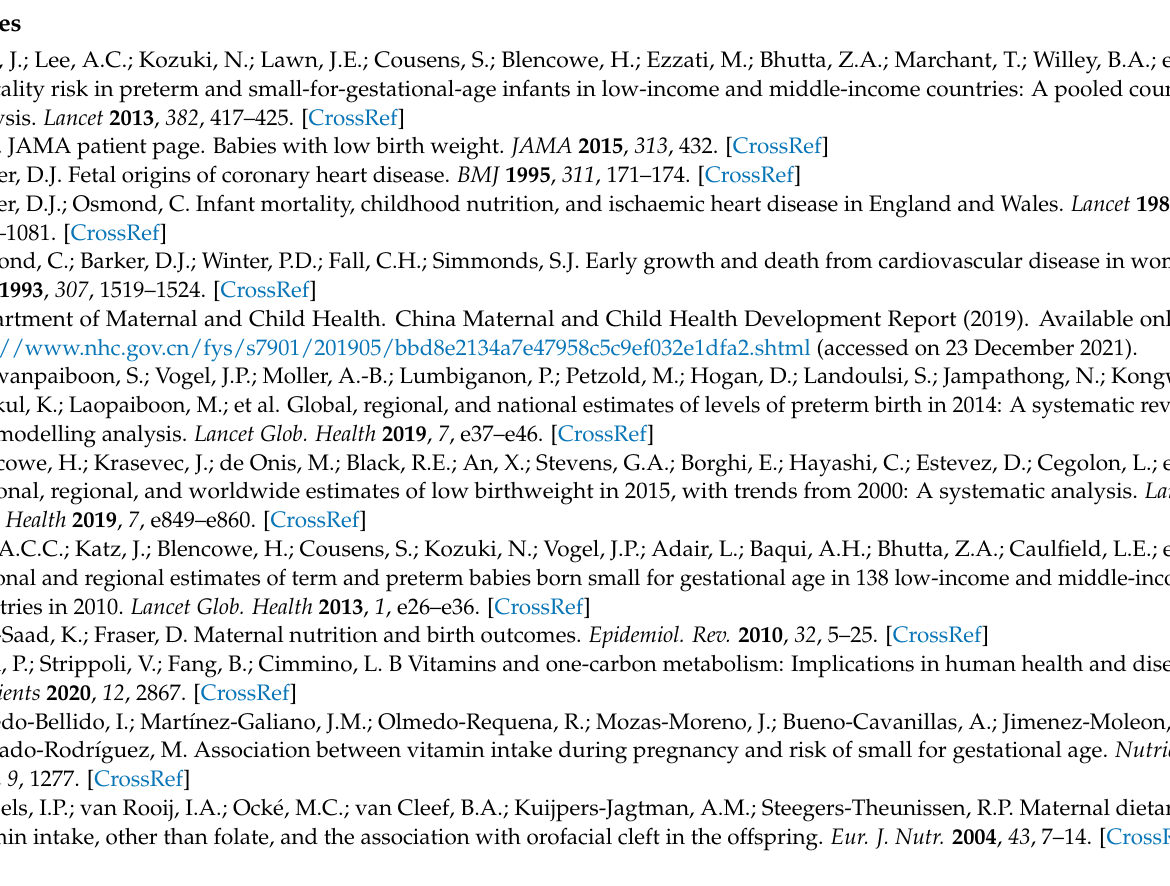
Table S2: Selected nutrient intakes according to quartiles of the high B-vitamin dietary pattern score; Figure S1: Flow chart of the selection of study participants; Figure S2: Associations of 1-SD increase in the high B-vitamin dietary pattern score with birth weight stratified by the use of B vitamins- containing supplements; Figure S3: Associations of 1-SD increase in the high B-vitamin dietary pattern score with birth weight Z score stratified by the use of B vitamins-containing supplements; Figure S4: Associations of 1-SD increase in the high B-vitamin dietary pattern score with SGA stratified by the use of B vitamins-containing